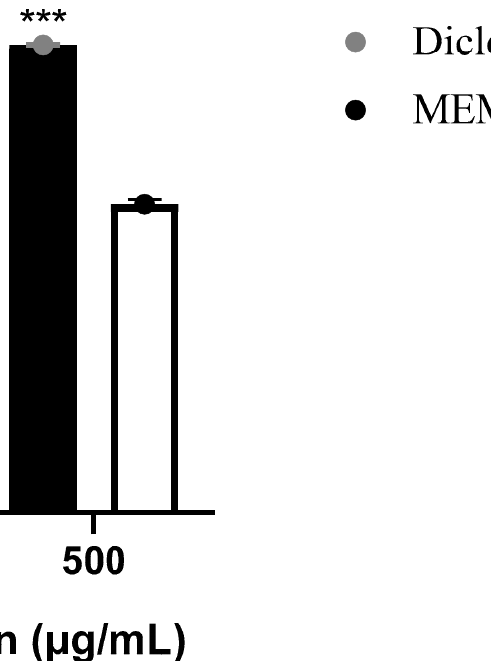
Figure 4. Anti-inflammatory activity of MEMC (methanol leaf extract of Molineria capitulata). Percentage of inhibition of protein denaturation of MEMC in comparison with reference standard (Diclofenac Na). Values are expressed as mean ± SEM ( n = 3) where data were analyzed by Sidak’s multiple comparison test and *** p value less than 0.001 is considered as statistically significant.